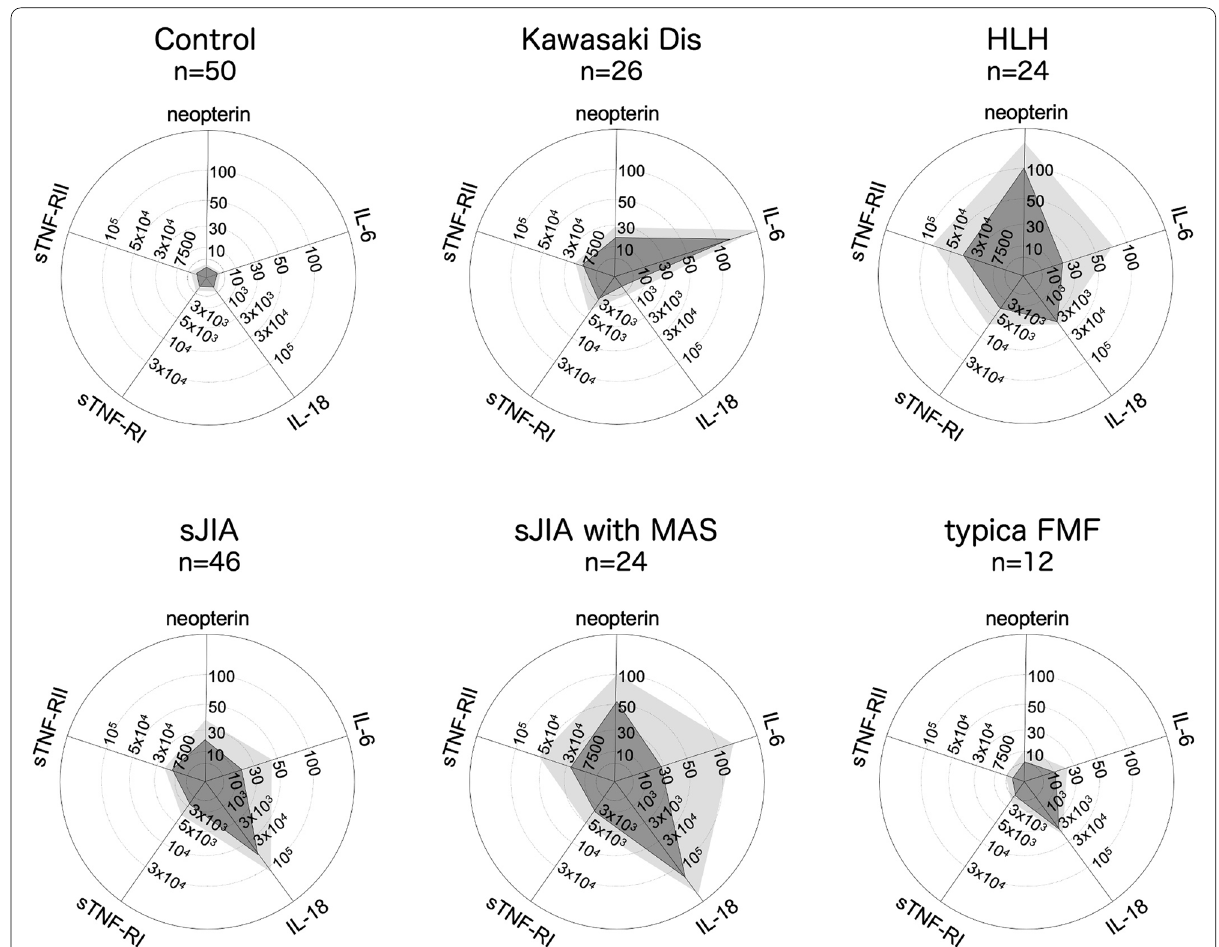
Fig. 3 Cytokine profiles of inflammatory illness. Cytokine profiles of patients with different inflammatory illnesses. Neopterin, IL-6, IL-18, sTNF-RI, and sTNF-RII were measured at the same time, and the profiles are shown in radar charts. Dark gray pentagon shows the means, and light gray pentagon shows standard deviation means of each +